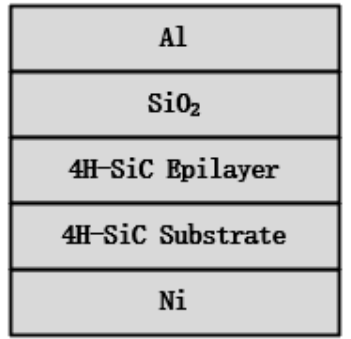
Figure 1. Schematic diagram of the nitrided SiO 2 / 4H-SiC metal–oxide–semiconductor (MOS) capacitors.